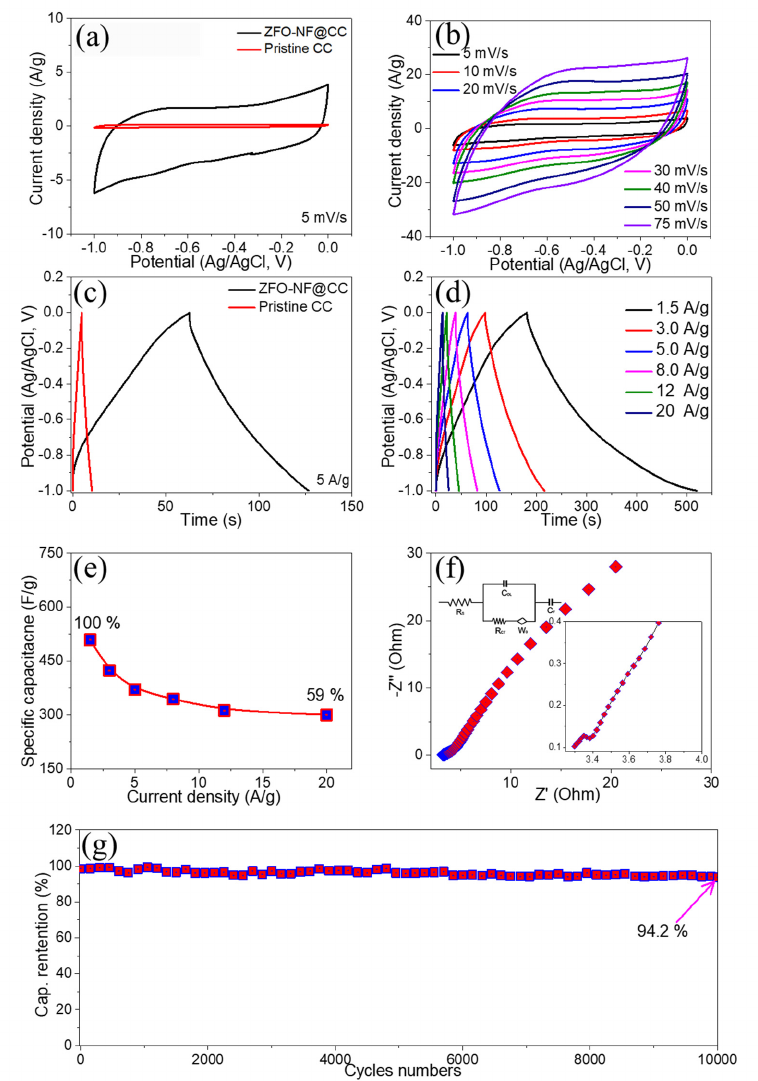
Figure 5. Electrochemical performance of ZnFe 2 O 4 nanoflakes: ( a ) comparative CV and ( b ) GCD curves of pristine CC and ZFO-NF@CC; ( c ) CV curves; ( d ) GCD curves; ( e ) specific capacitance versus current density; ( f ) Nyquist plot of EIS; ( g ) capacitance retention versus number of